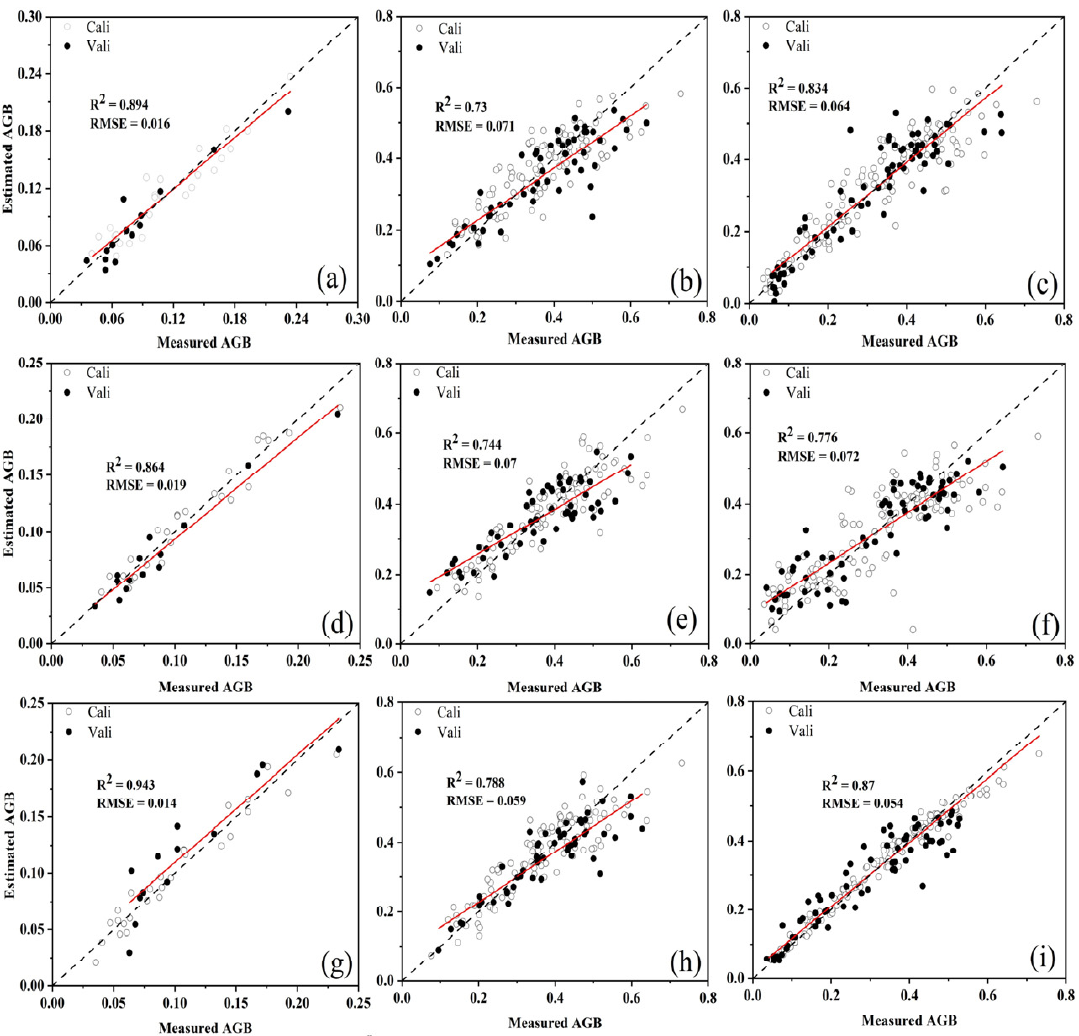
Figure 13. Validation of aboveground biomass (AGB) estimation models established by best performing spectral, image, and combination features. Effective wavelengths for the following stages: ( a ) seedling, ( b ) post-seedling, ( c ) all stages. ONDTIS for the following stages: ( d ) seedling, ( e ) post-seedling, ( f ) all stages. OTEX + effective wavelengths for the following stages: ( g ) seedling, ( h ) post-seedling, ( i ) all stages.